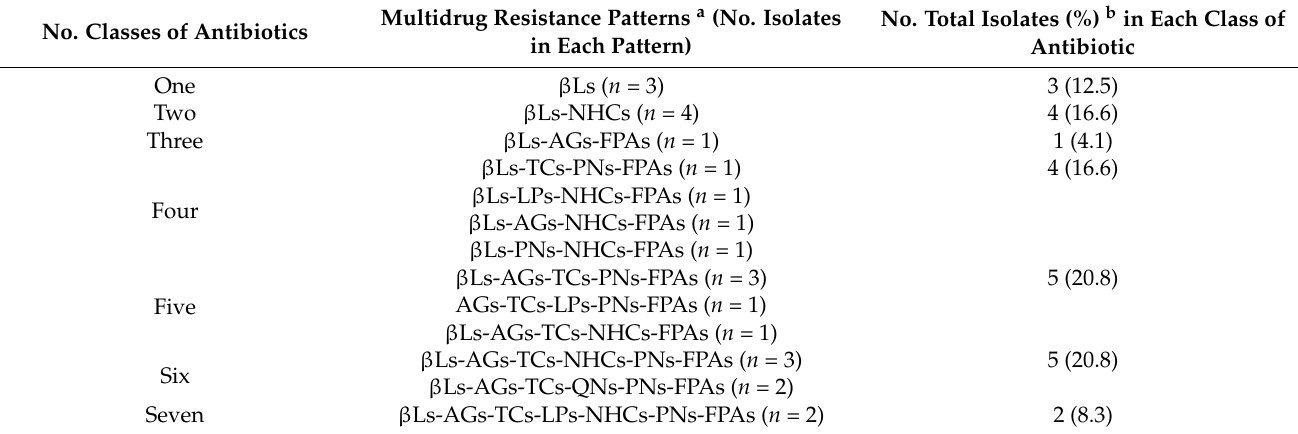
Table 2. Multidrug resistance class patterns of E. coli isolates ( n = 24) from food